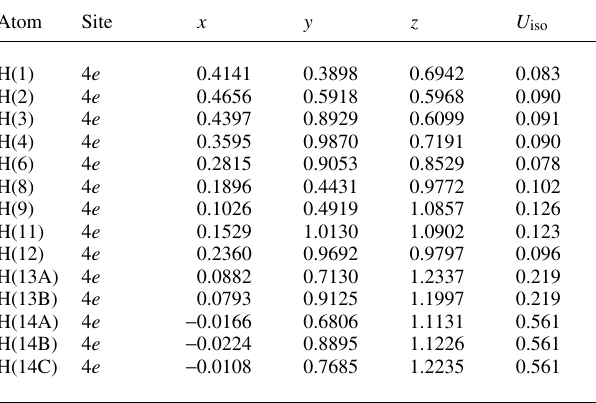
Table 2. Atomic coordinates and displacement parameters (in Å 2 )